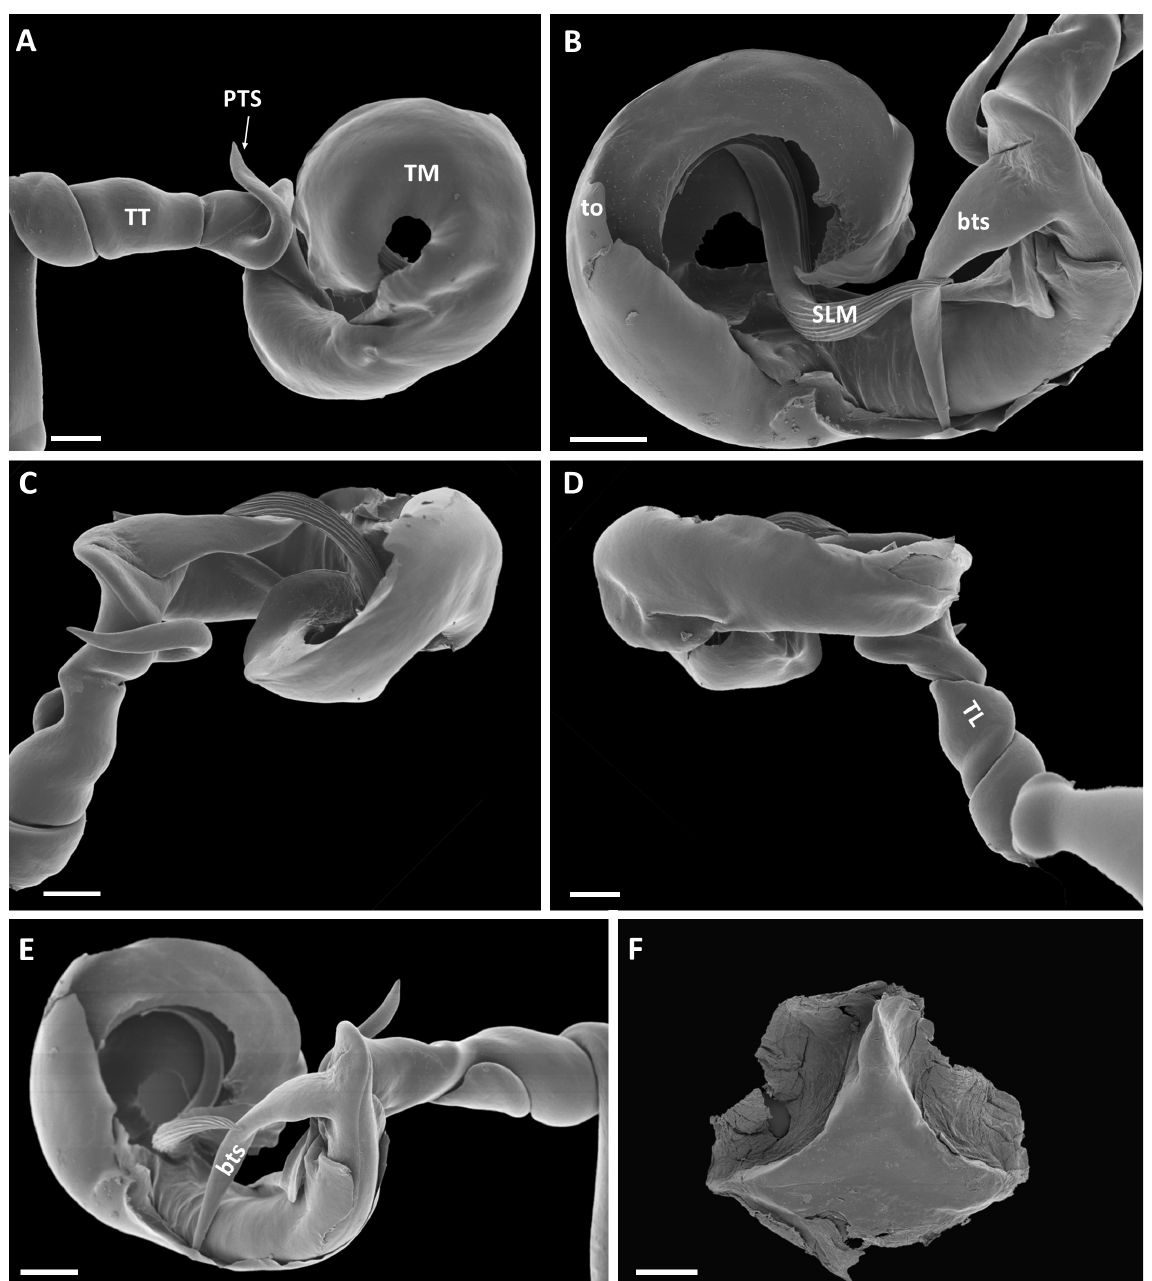
Fig. 22. Calyptomastix zoltani sp. nov., holotype, ♂ (NHMD 621719). A–E . Left gonopod telpodite. A. Anterior view. B, E. Posterior view. C. Ventral view. D. Dorsal view. F . Sternum 9. Abbreviations: bts = basal telomeral spine; PTS = post-torsal spine; SLM = solenomere; TL = torsotope lobe; TM = telomere; to = tongue-like lobe; TT = torsotope. Scale bars = 0.1